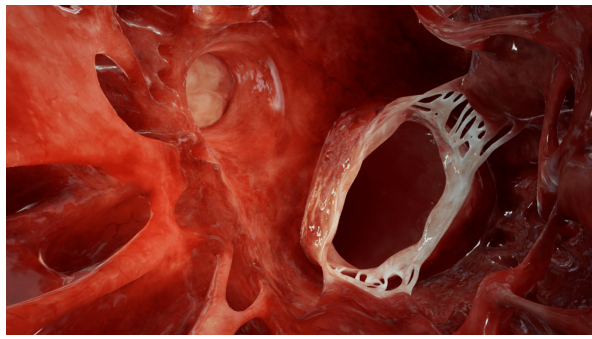
Fig. 1. Image of VR application. Normal mitral valve. Permis- sion for all images given by Sharecare YOU.